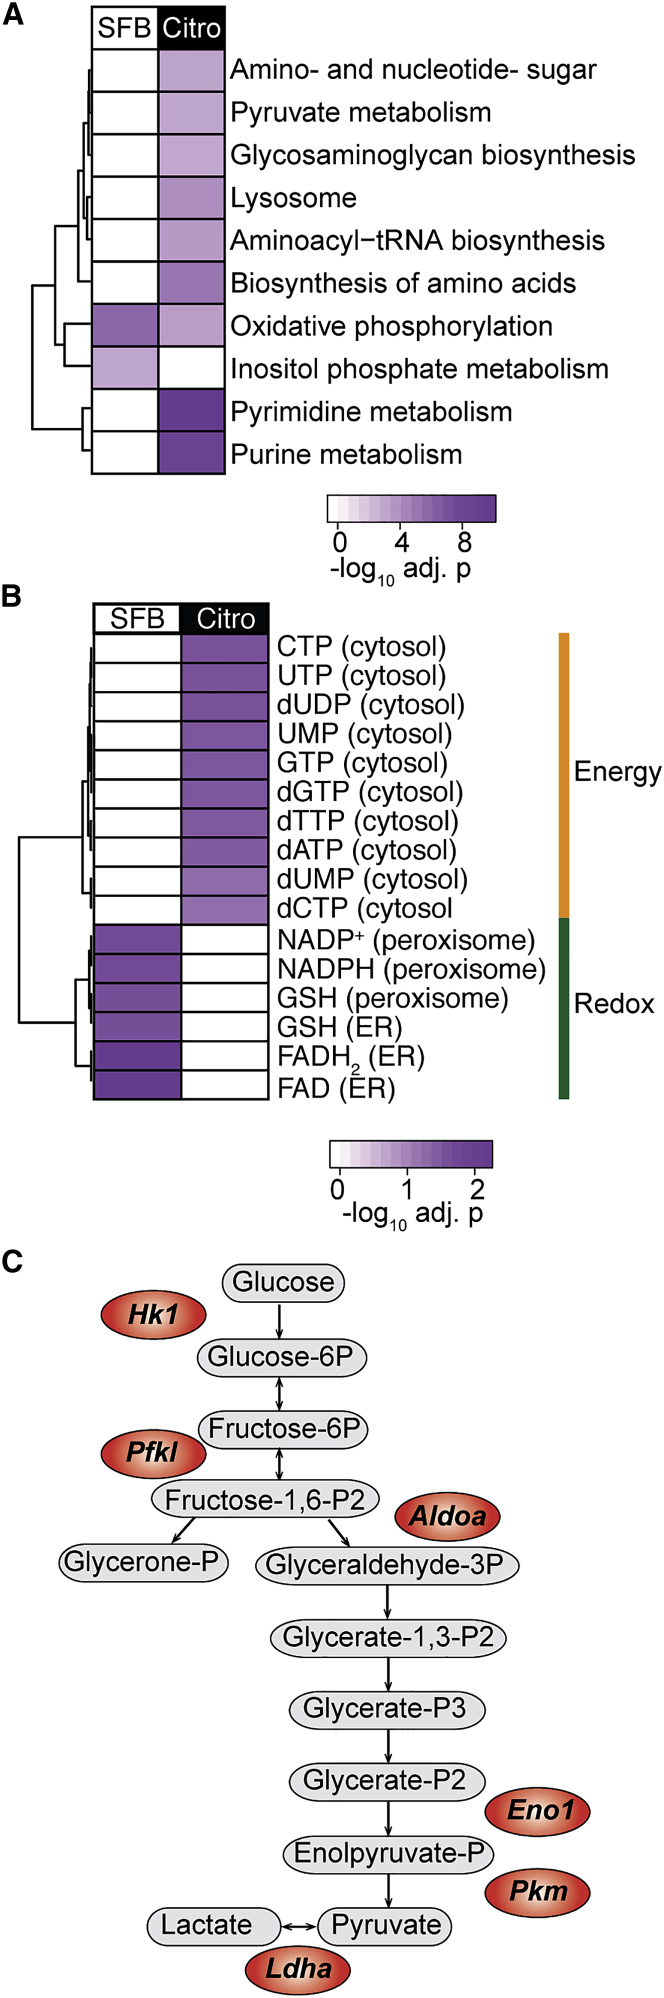
SFB- and C.-rodentium-elicited intestinal Th17 cells display different metabolic phenotypes(A) Kyoto Encyclopedia of Genes and Genomes (KEGG) metabolic pathways enriched in SFB- and C.-rodentium-elicited colonic Th17 cells, on the basis of upregulated genes with adjusted p < 0.001.(B) Selection of differentially upregulated reporter metabolites involved in energy generation and redox reactions in SFB- and C.-rodentium-elicited colonic Th17 cells (adjusted p < 0.05).(C) Metabolism-related genes increased in C.-rodentium-induced colonic Th17 cells (adjusted p < 0.05) (in red) as well as the associated reactions involved in glycolysis. See also Table S1.